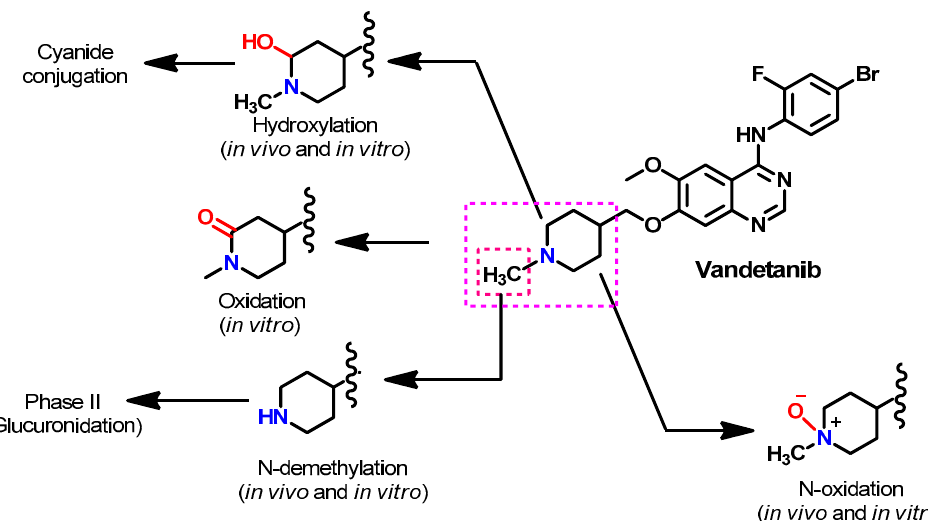
Figure 66. Proposed metabolic pathways of vandetanib (in vitro and in vivo).